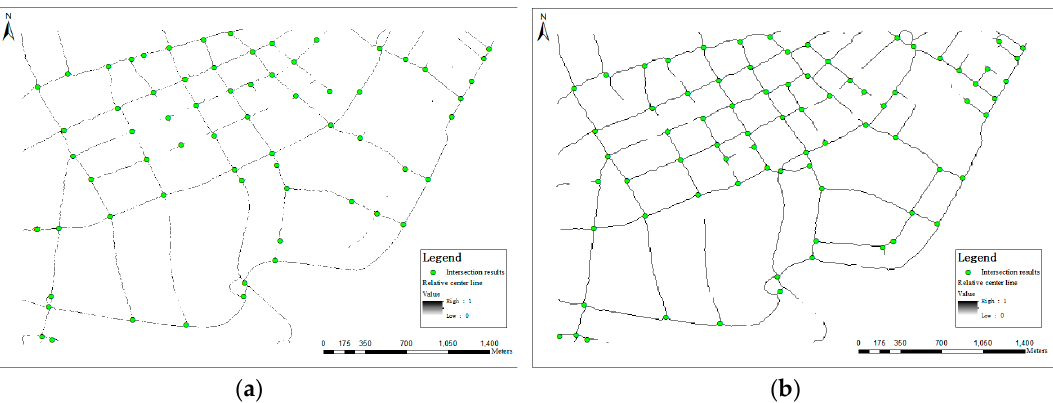
Figure 6. Intersection and relative center line extraction results from different resolutions via rasterization: ( a ) 2.5 m results; ( b ) 5 m results.